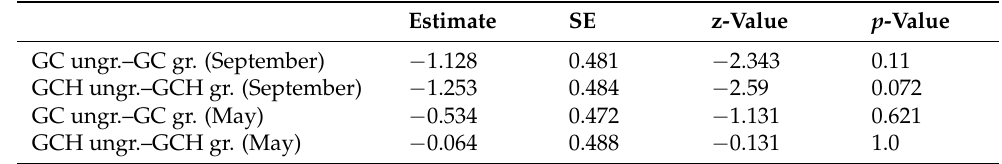
Table A23. Differences in species richness of eurytopic carabid beetles, comparing the grazed pastures and ungrazed strips of the grass–clover (GC) and the grass–clover herbs (GCH) in May/June and